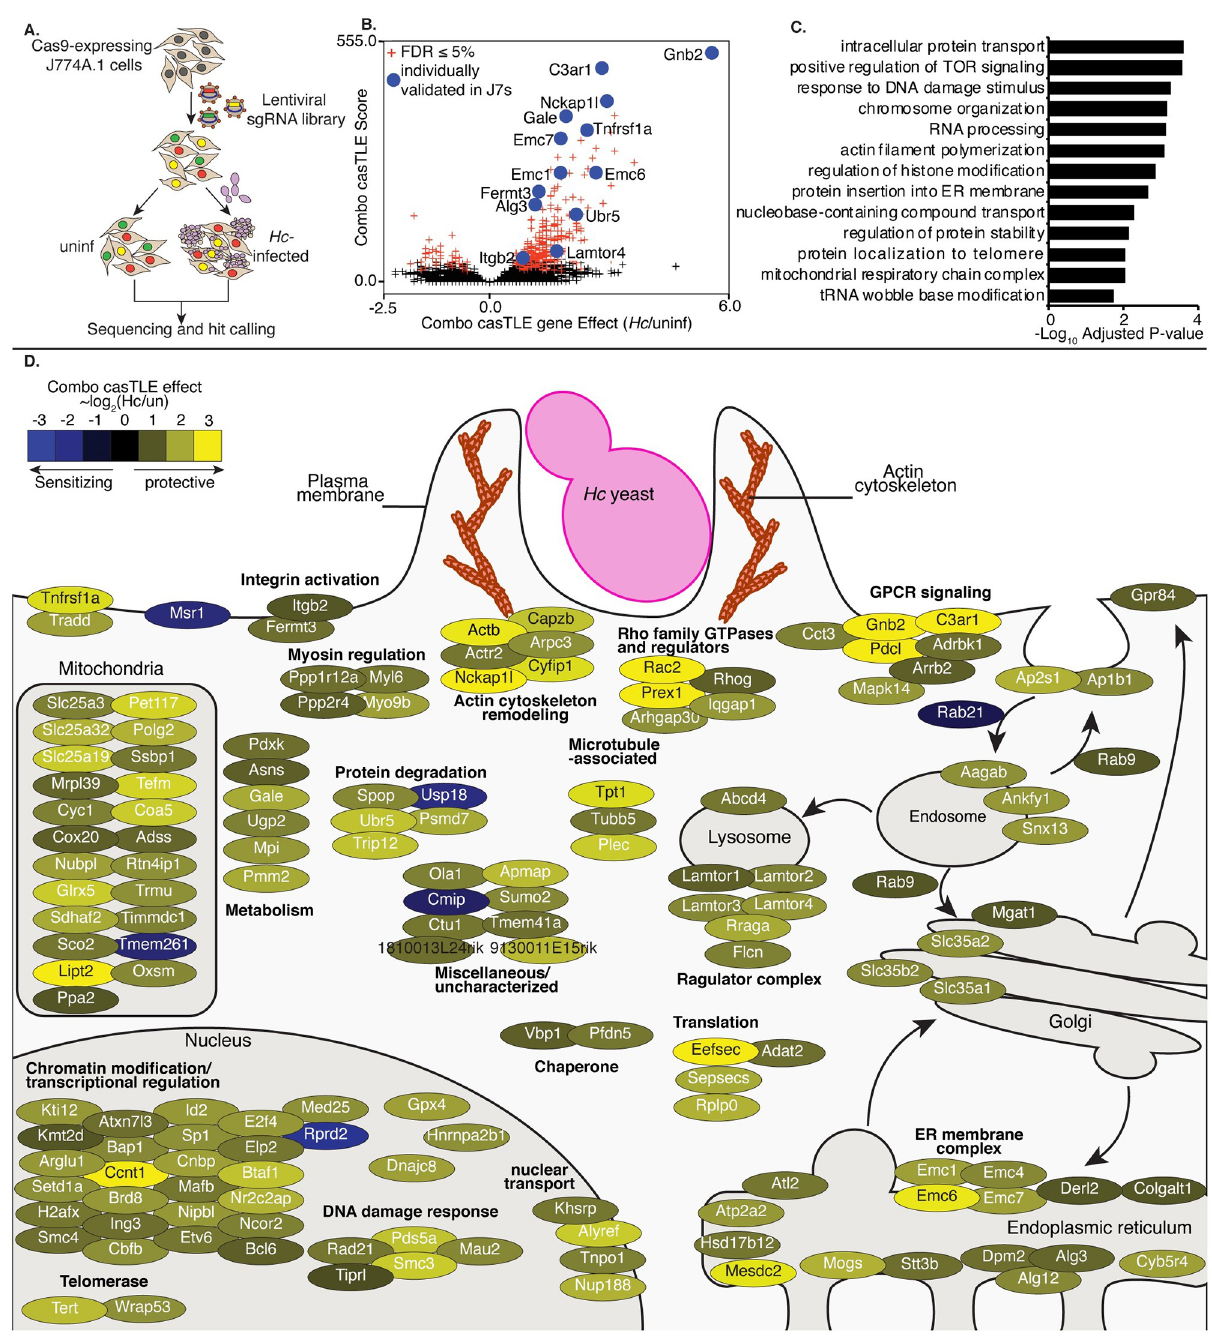
Fig 1. A pooled CRISPR screen identifies genes required for macrophage susceptibility to infection with Hc . A. Diagram of screen approach. Cas9-expressing J774A.1 macrophage-like cells were transduced with a library of sgRNAs, challenged with Ura5-deficient Hc yeast, and subjected to 2–3 pulses of uracil treatment followed by recovery. sgRNAs amplified from Hc -infected and uninfected cells were deep-sequenced, and sequences were analyzed to identify guides that became enriched or depleted in the Hc -infected pool relative to the uninfected pool. B. Volcano plot showing the confidence score (casTLE score) versus the effect size (casTLE effect) for all genes. Genes that pass the 5% FDR cutoff are colored red, and genes individually validated in J774A.1 cells are labelled and colored in blue. C. Adjusted P-values for selected GO biological process annotations enriched in the screen hits. D. The 150 highest-scoring genes identified in the screen grouped based on their annotated function and localization in a cell, functional categories or complexes of genes are noted. Genes are colored according to their gene effect estimate, where yellow indicates enrichment in the Hc infected pool and blue indicates